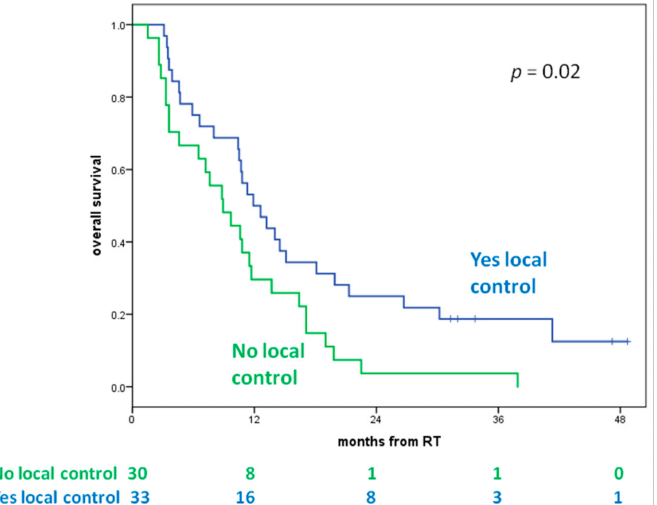
Figure 3. Overall survival according to local control. No local control: patients who did not achieve local control; Yes local control: patients who achieved local